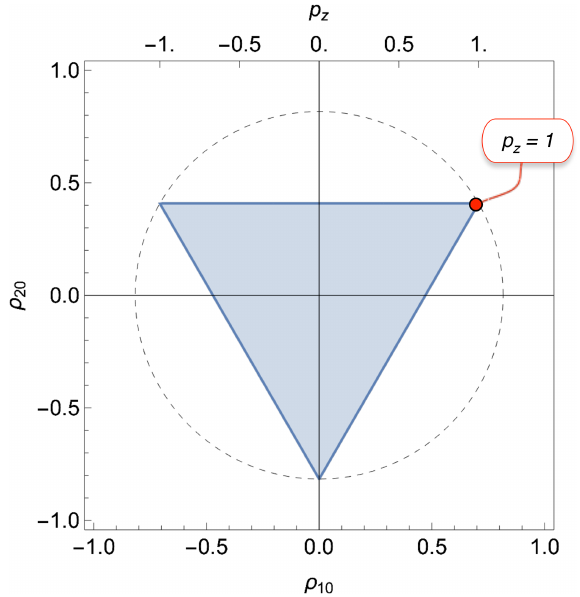
Figure 1. Physical bounds on the rank-1 and rank-2 polarization moments for isolated spins I = 1. The shaded triangle shows the physically accessible region. The vertices correspond to pure-state density operators for each of the three spin-1 Zeeman states. The √ radius of the dashed circle is 2 / 3. The rank-1 polarization moment ρ 10 is related to the z polarization p z through Eq. (18). The red circle indicates a state with maximum Zeeman